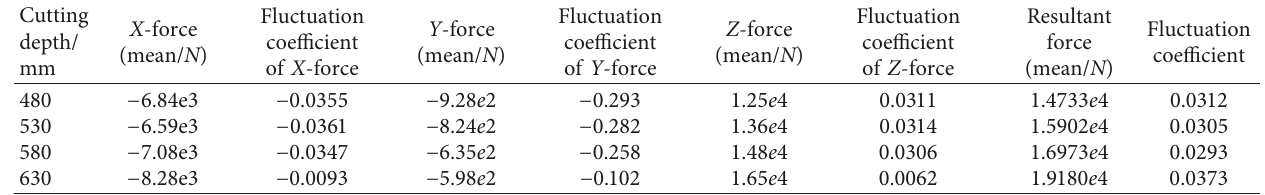
Table 6: The relationship between the cutting depth and the three-directional force of the drum.